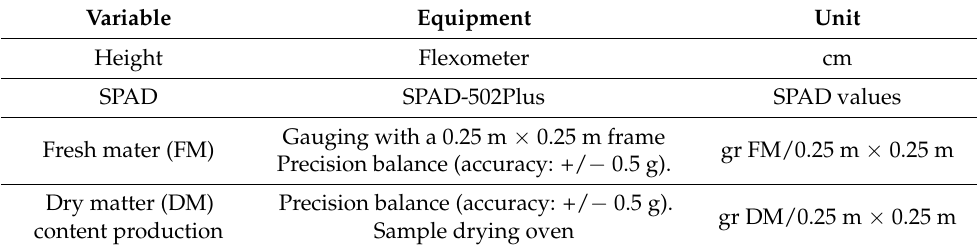
Figure 2. Image examples of manual measurements and sample collection in the field. ( a ) SPAD values measured in the plot G10; ( b ) height measurement collected in the plot G03; ( c ) forage fresh matter production measures in the plot G10; ( d ) weighing fresh matter; ( e ) oven drying of samples; and ( f ) weighing dry matter. Table 1. GTD variables and the equipment used for data